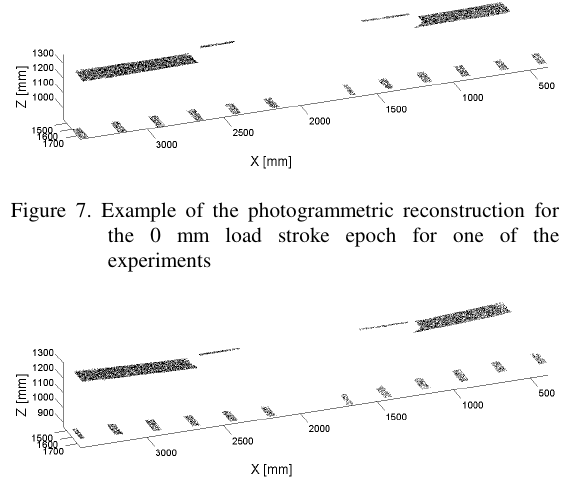
Figure 8. Example of the photogrammetric reconstruction for the 65 mm load stroke epoch for one of the